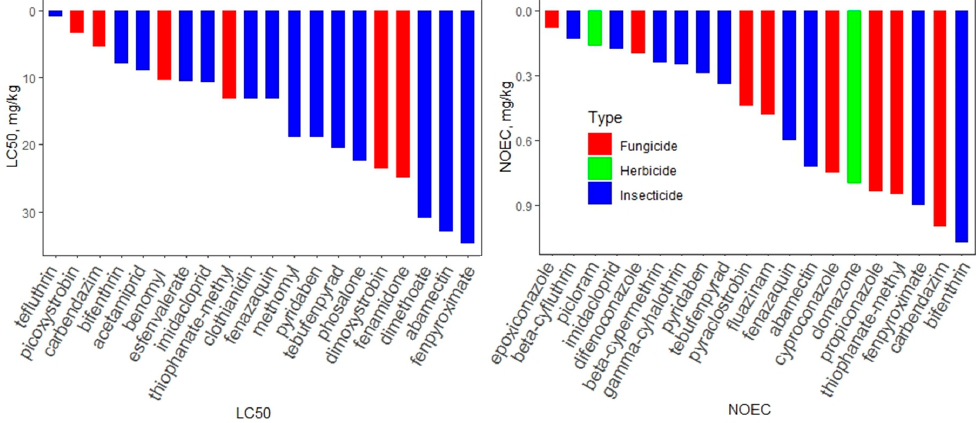
Figure 9. Ratings of the most toxic pesticides for earthworms.